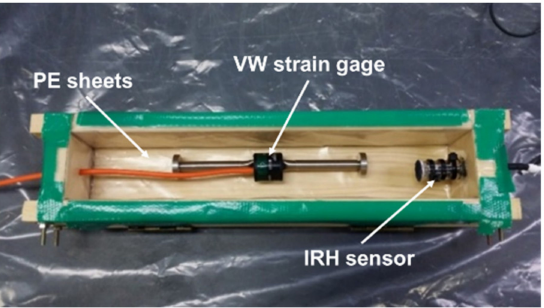
Figure 4. Test setup for autogenous shrinkage and internal relative humidity (IRH) measurements.